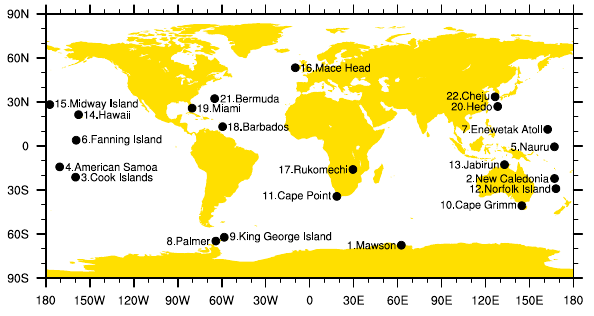
Fig. 6. Locations of the measurement stations analyzed by Huneeus et al. (2010) and compared to ECHAM/MADE-in results in Fig.